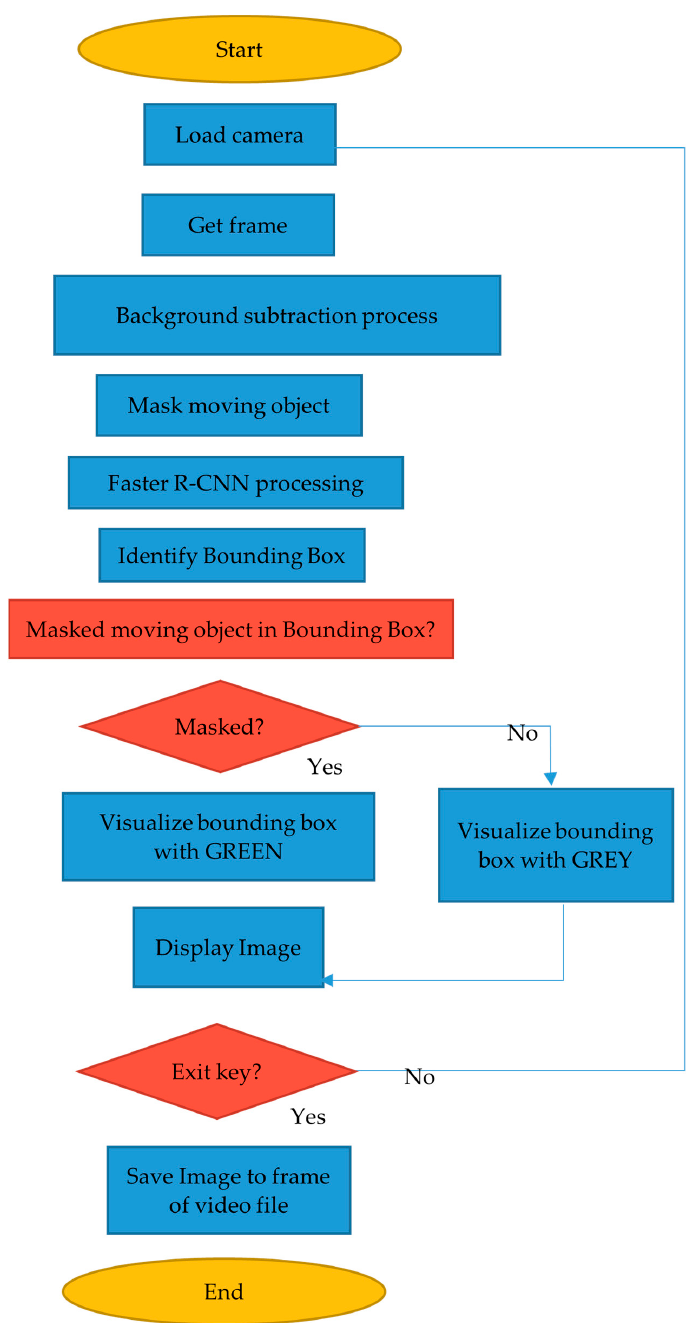
Figure 7. Process flow for the Faster R-CNN algorithm with moving object detection.